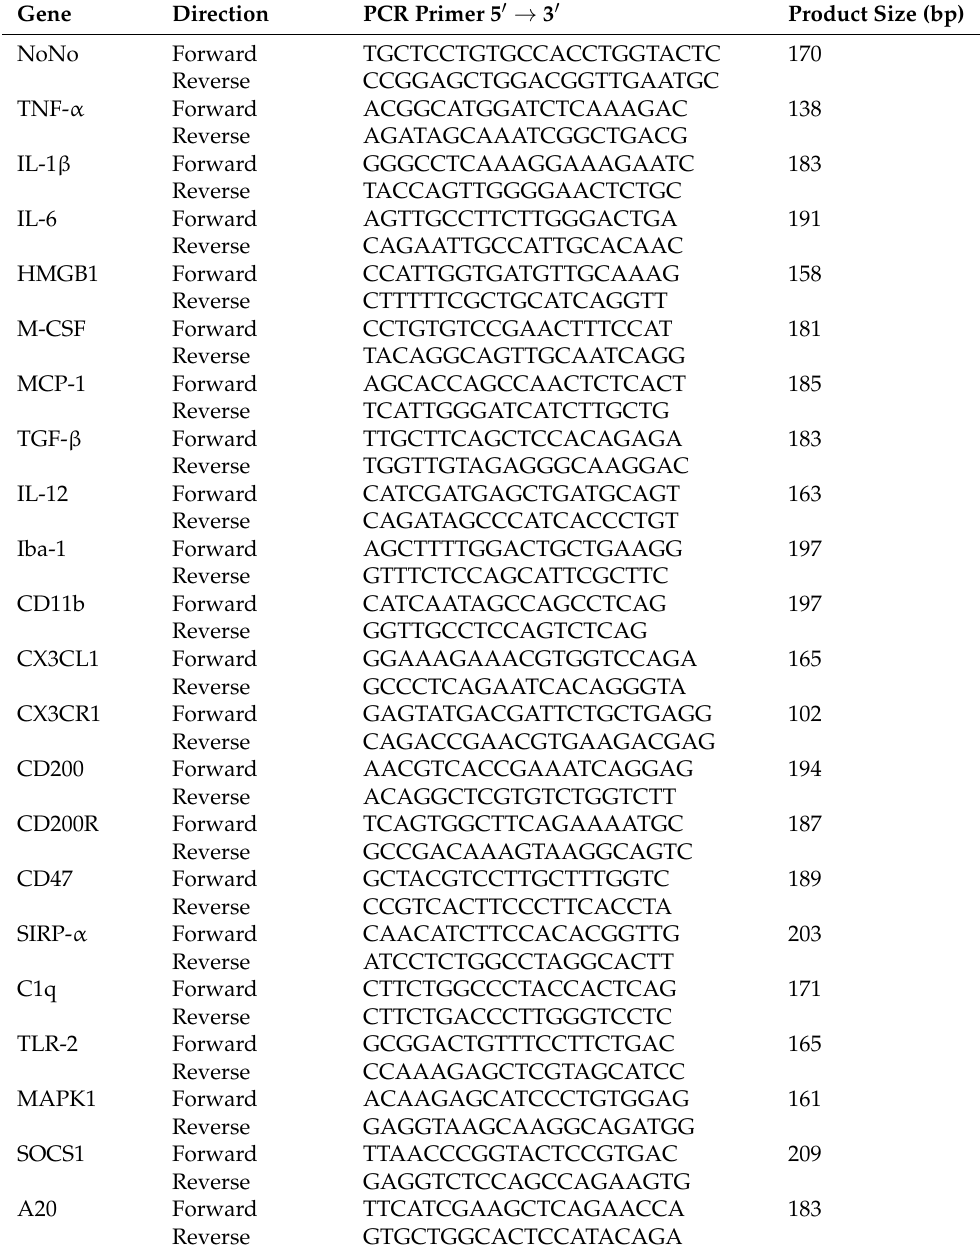
Table A2. Primer